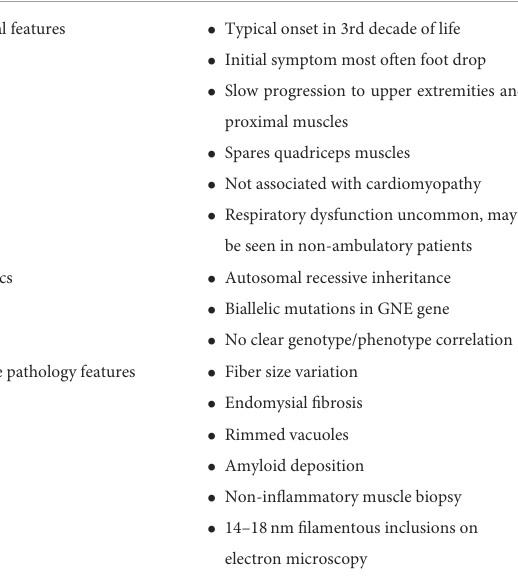
TABLE 2 Common features of GNE